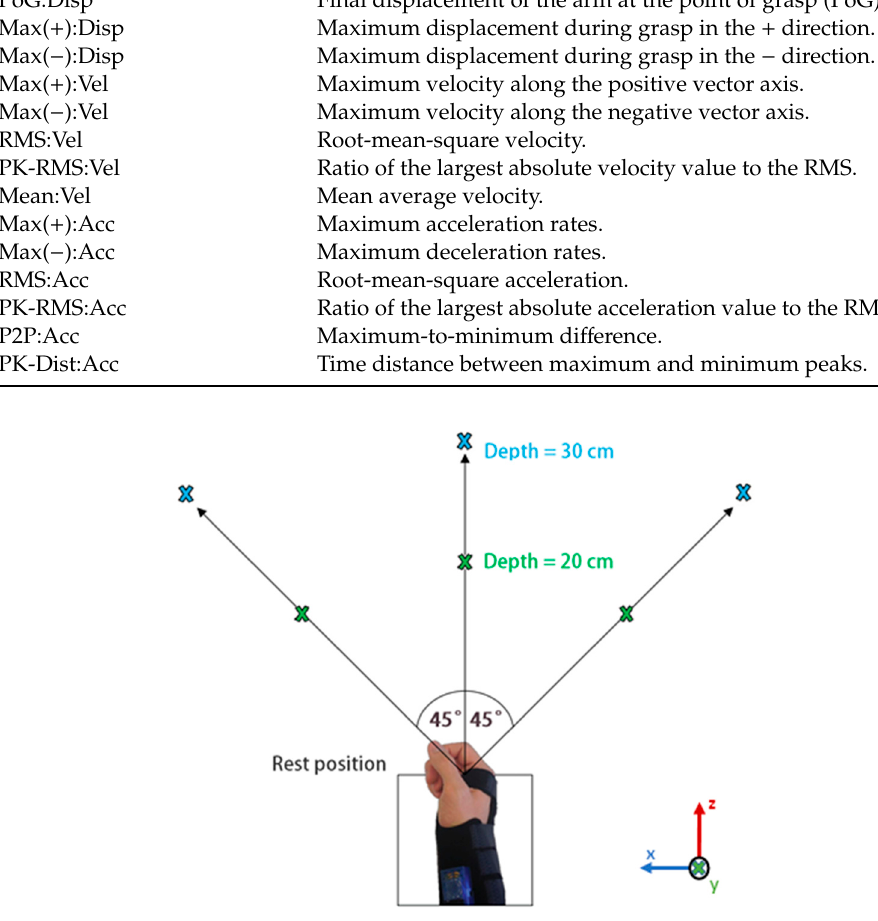
Figure 3. Object locations during data collection at − 45 ◦ , 0 ◦ , and 45 ◦ with depths of 20 cm and 30 cm. The same locations are used at three elevation levels: ascending, descending, and table height.